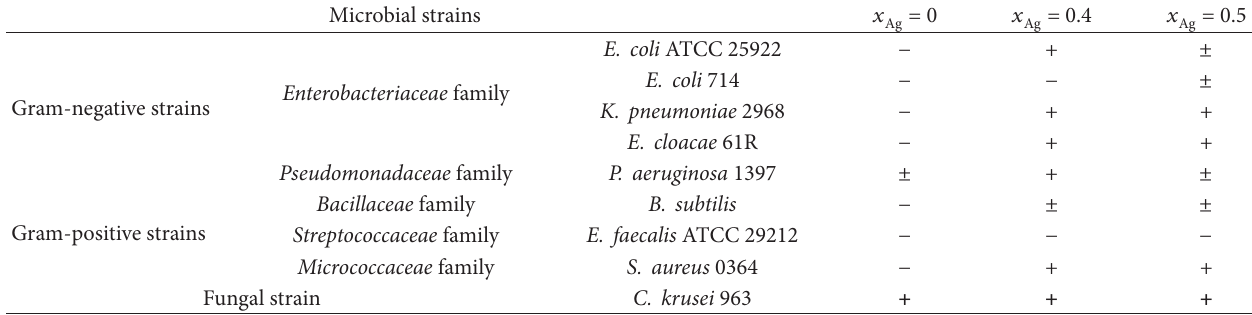
T 1: e results of the qualitative screening of the antimicrobial activity of Ag:HAp compounds against different gram-positive and gram- negative bacteria, as well as fungal